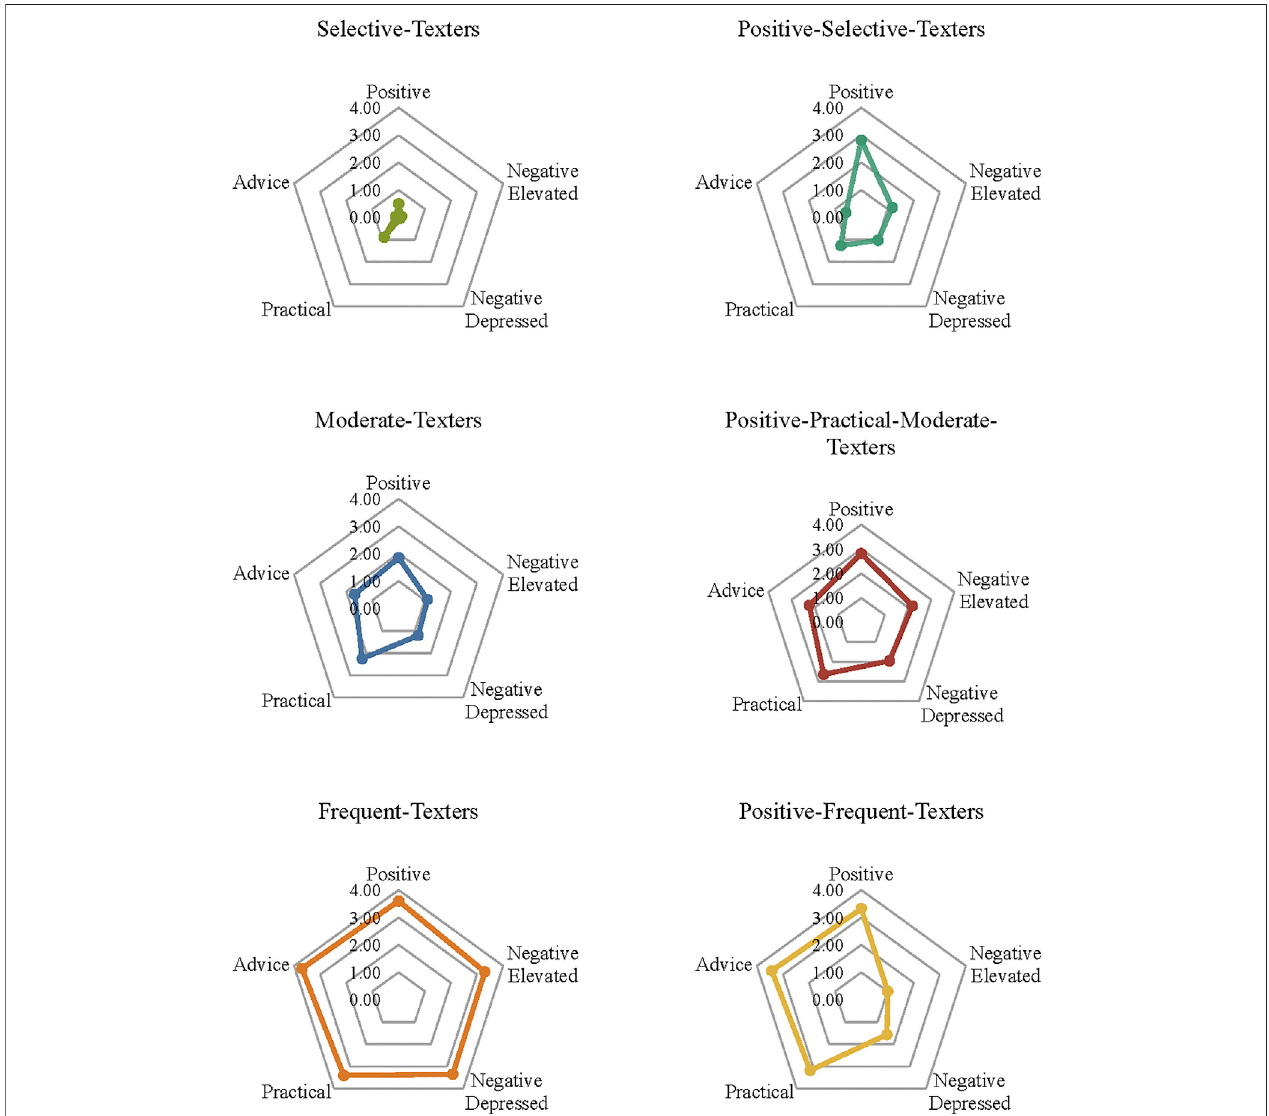
FIGURE 1 | Texting clusters. Scale: 0 (cid:1) never, 1 (cid:1) rarely, 2 (cid:1) sometimes, 3 (cid:1) often, 4 (cid:1) always.